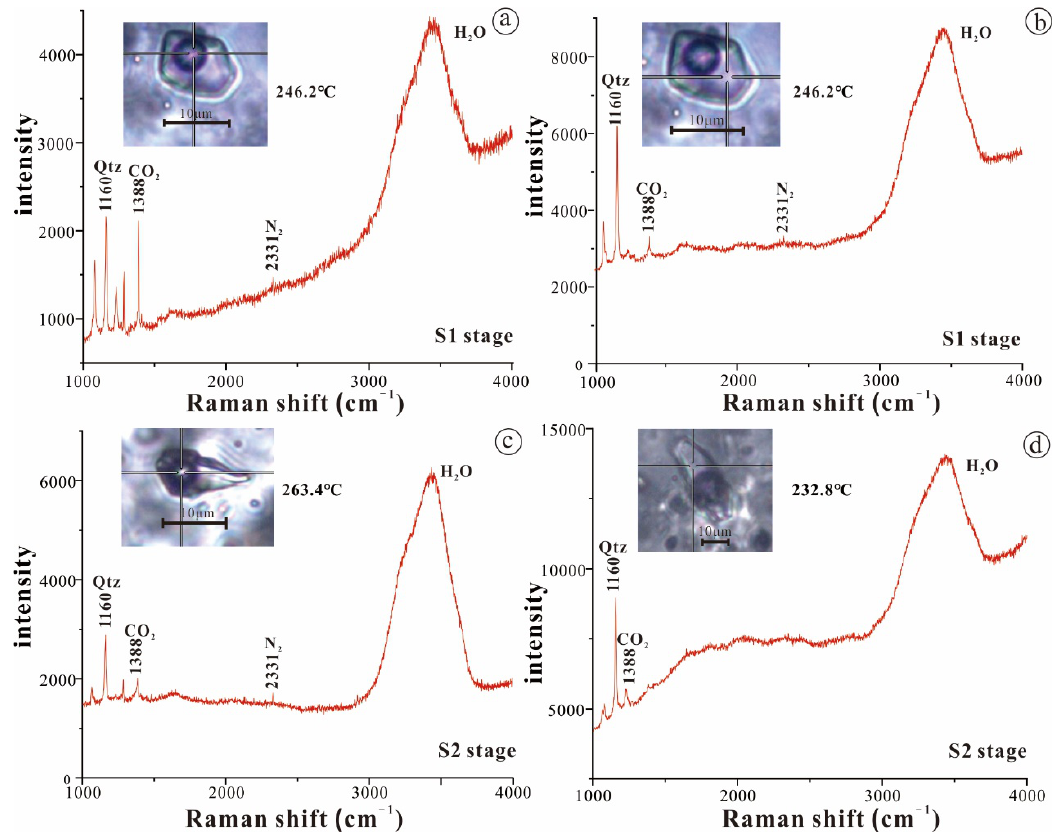
Figure 9. Laser Raman spectra of fluid inclusions in the Hongqiling Sn-W polymetallic deposit. ( a ): S1 stage fluid inclusion vapor phase; ( b ): S1 stage fluid inclusion liquid phase; ( c ): S2 stage fluid inclusion vapor phase; ( d ): S2 stage fluid inclusion liquid phase.